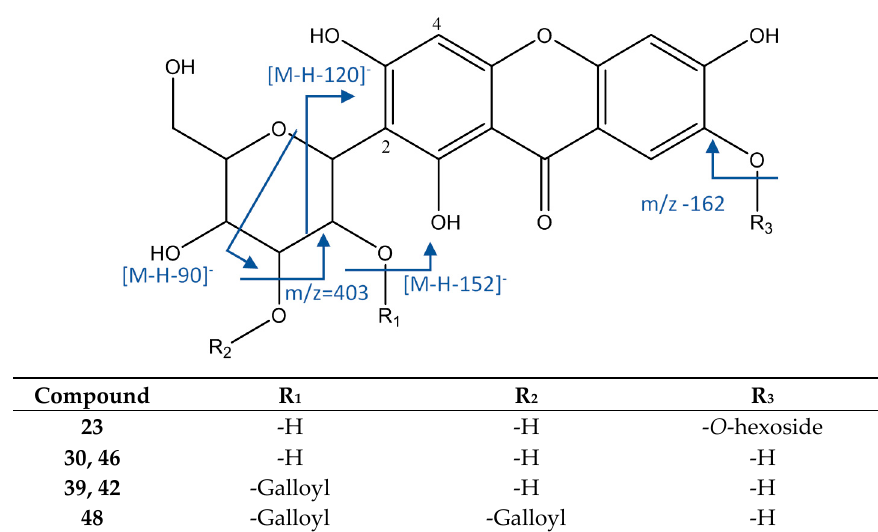
Figure 10. Structure and fragments of xanthonoids.